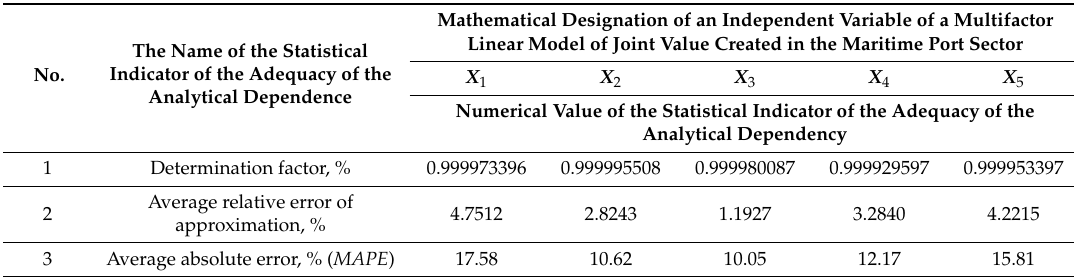
Table 4. Statistical indicators of the adequacy of the obtained analytical dependencies (Fourier series) of independent variables of the multifactor linear model of joint value created in the maritime